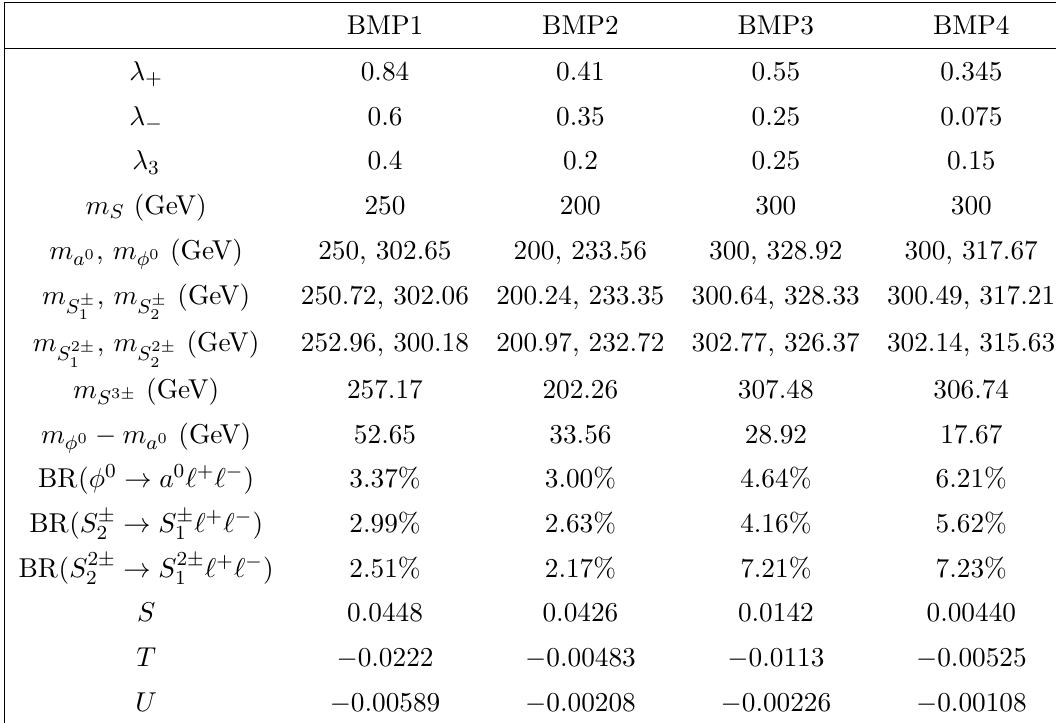
Table 2 . Information of four